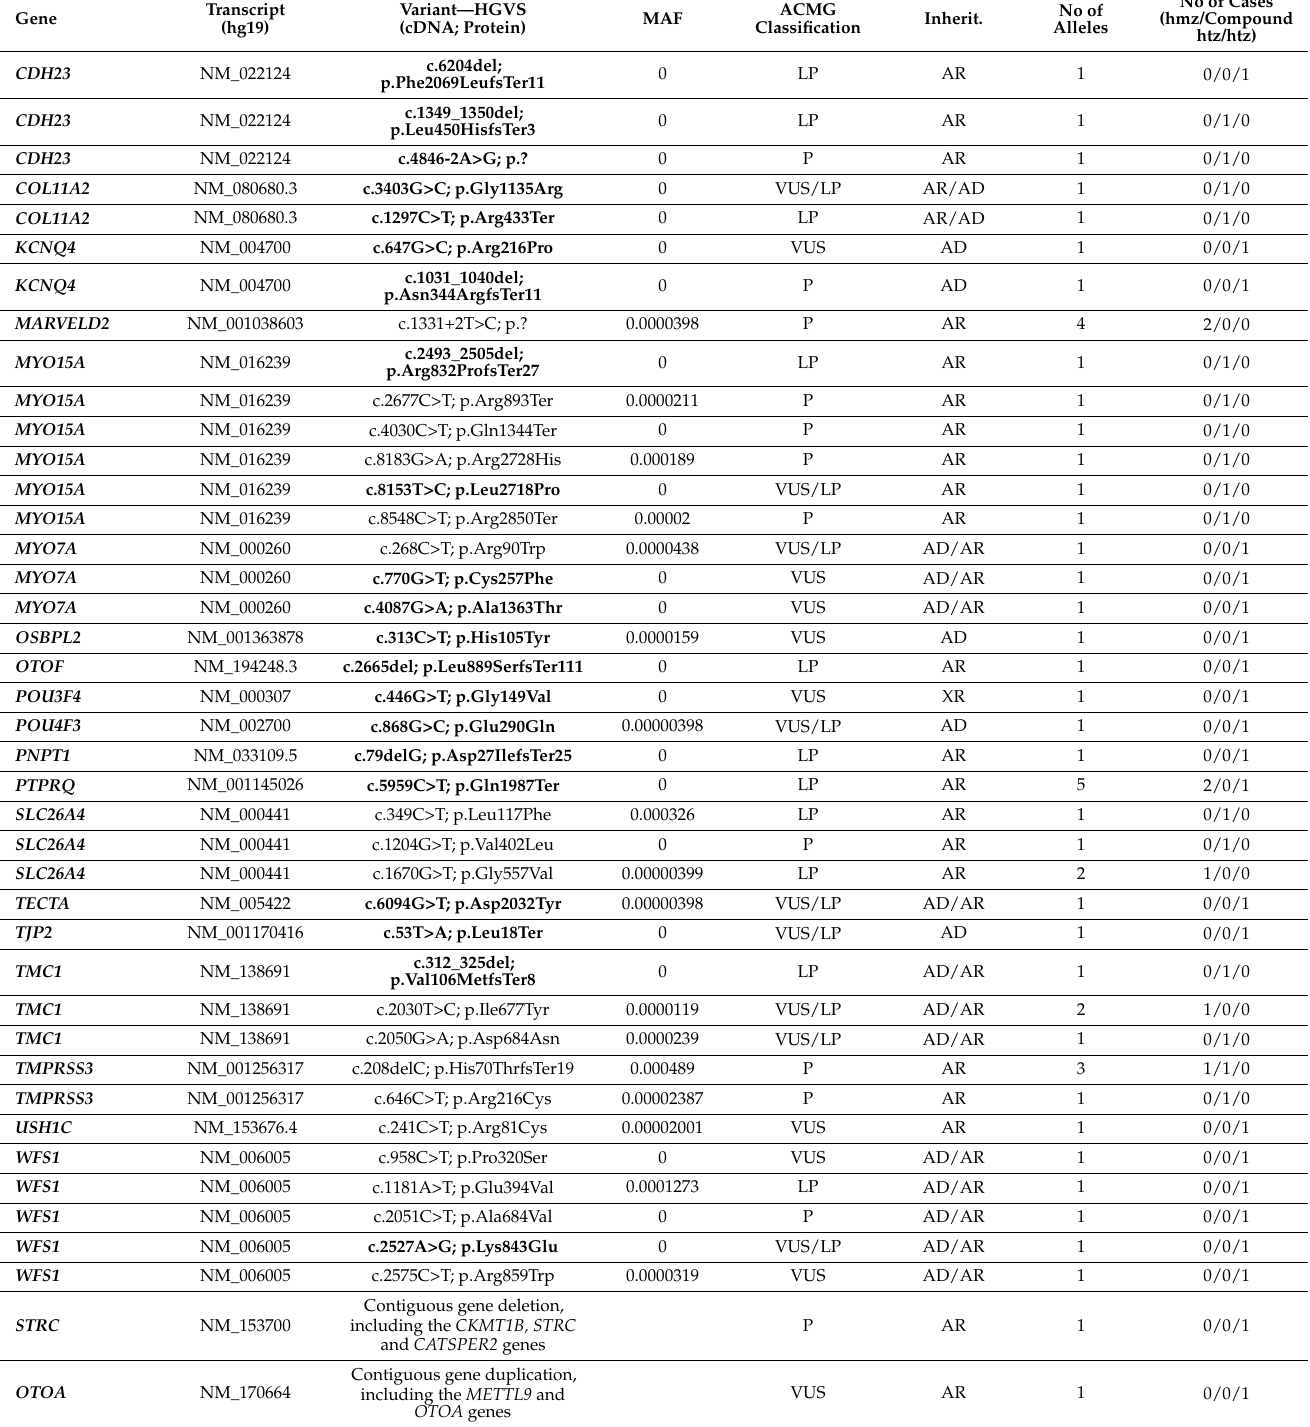
Table 2. Characteristics of rare variants identified in the Hungarian NSHL patient